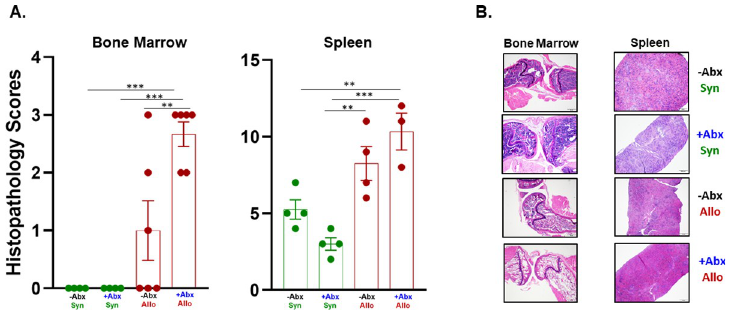
Fig 3. Histopathological analysis of bone marrow and spleen. A). Blinded histopathology scores were quantified for bone marrow and spleen obtained from mice in the 4 groups described in Fig 1 at 4 weeks post T cell transfer. B). Representative histological images of bone marrow and spleen from each group (40x total magnification). Asterisks ( � ) designate significant differences between groups. ( �� p < 0.01; ��� p < 0.001).